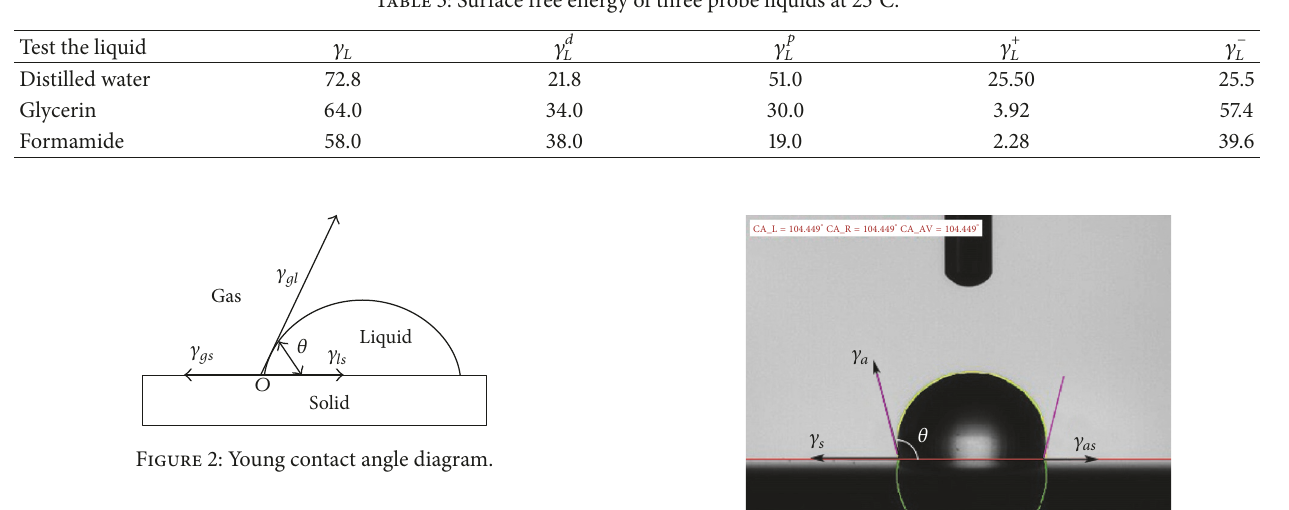
Table 5: Surface free energy of three probe liquids at 25 ∘ C.